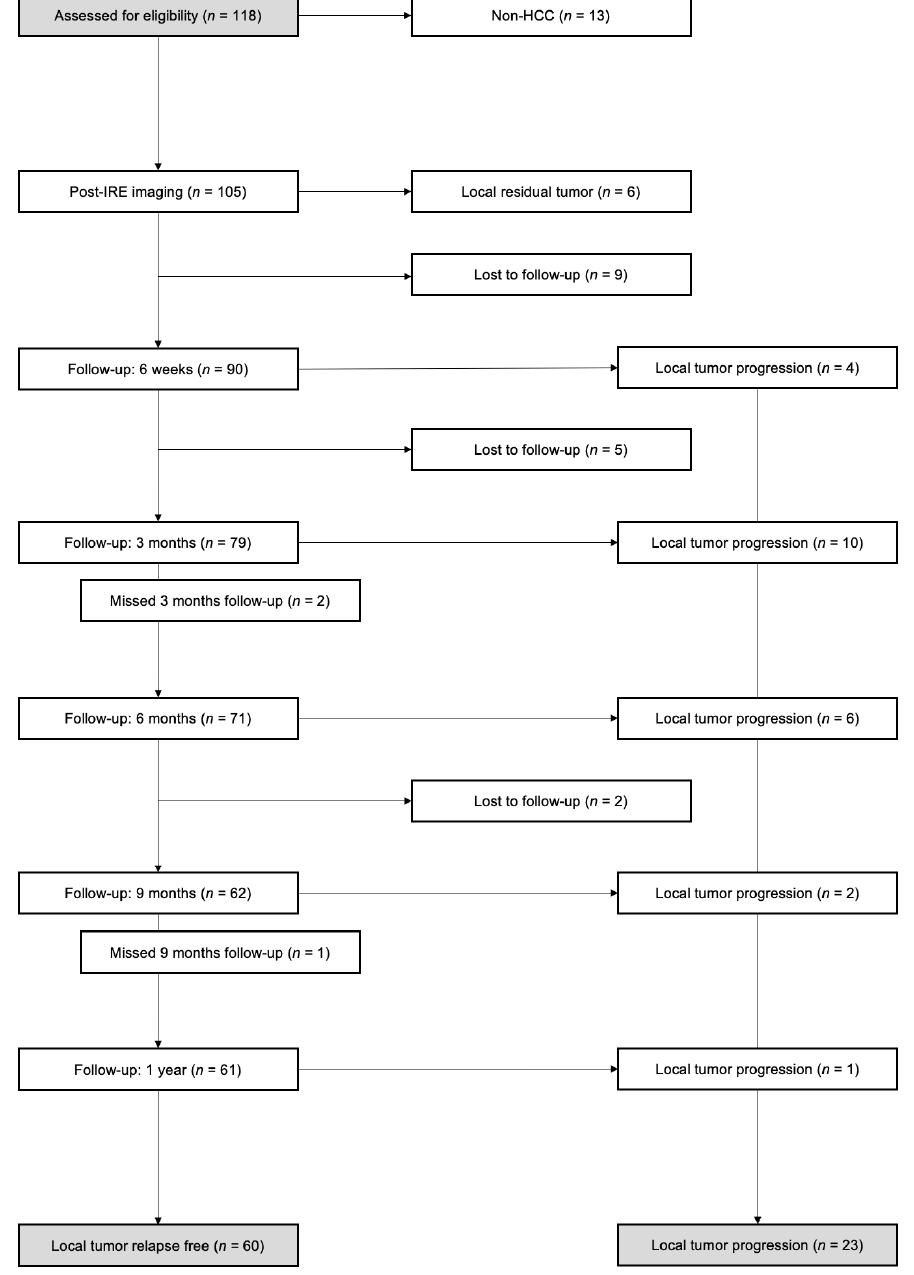
Figure 1. Number of patients during follow-up.